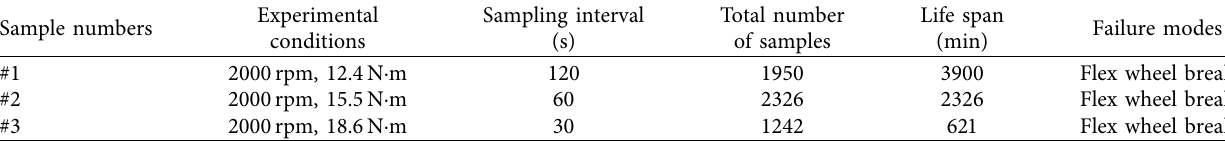
Table 2: List of harmonic reducer test